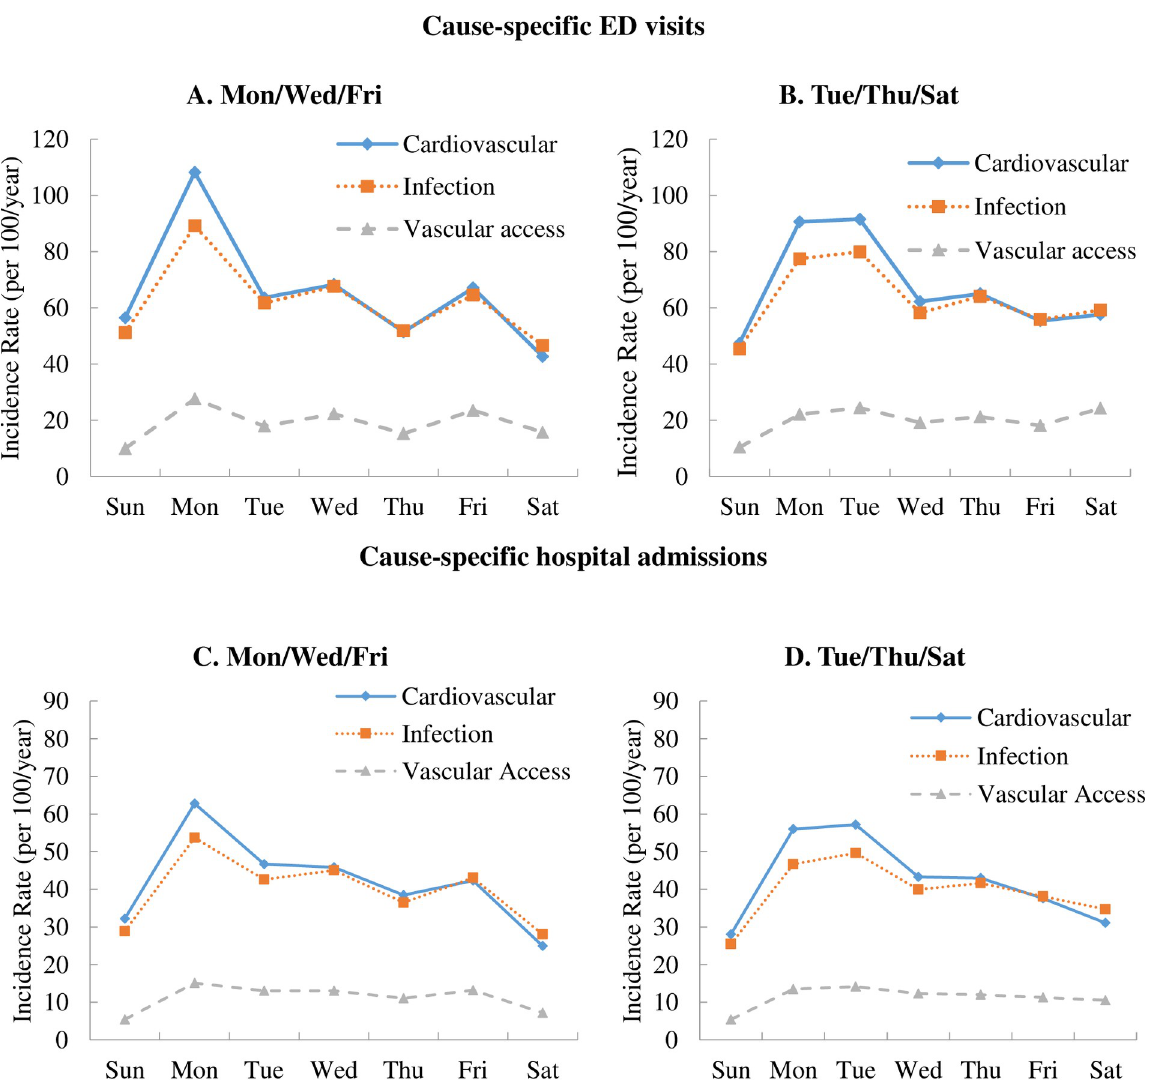
Fig 3. Adjusted incidence rates (per 100/year) of (A, B) cause-specific ED visits and (C, D) cause-specific hospital admissions for in-center HD patients in 2013, by dialysis schedule (MWF or TTS), day of the week, and primary diagnosis . Incidence rates were adjusted for age, sex, race/ethnicity, the Charlson Comorbidity Index score, HD vintage, HD session length, Kt/V, IDWG, and